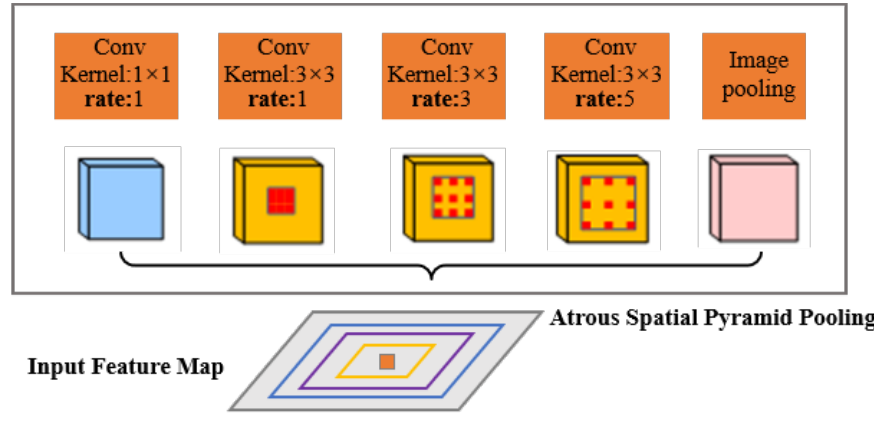
Figure 9. Illustration of the proposed ASPP module structure comprising multiple parallel levels: a 1 × 1 convolution; three 3 × 3 dilated convolutions with dilation rates of 1, 3, 5, respectively; and image